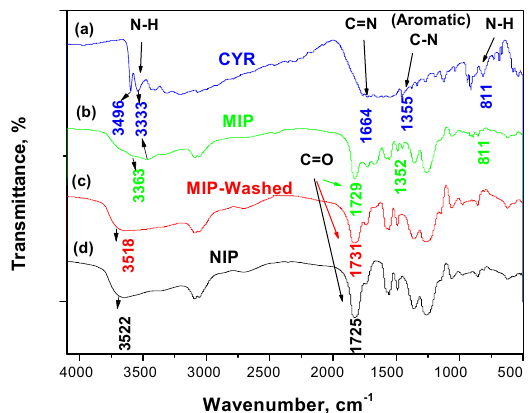
Figure 3. FT-IR spectra for: ( a ) CYR; ( b ) DCP / MIP, ( c ) MIP / washed and ( d ) NIP beads.